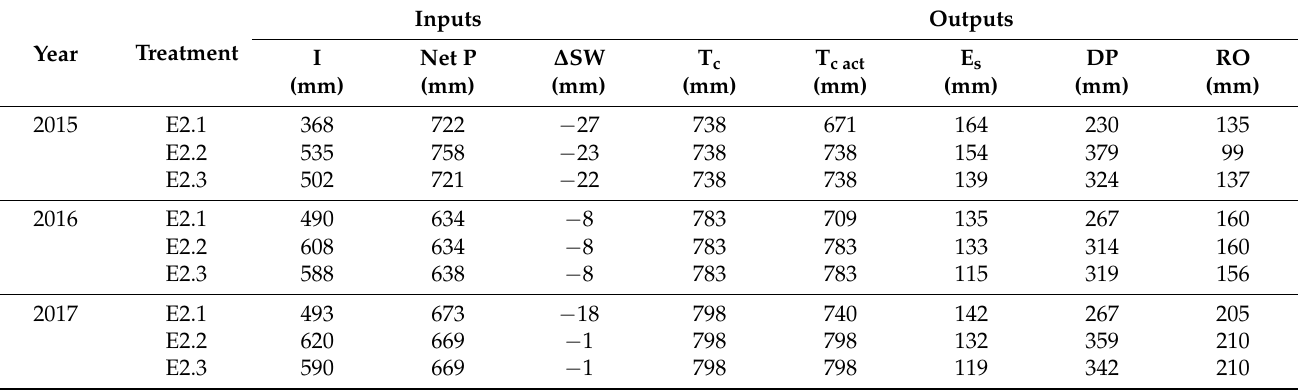
Table 15. Components of the annual water balance relative to the E2 growing seasons following the A&P